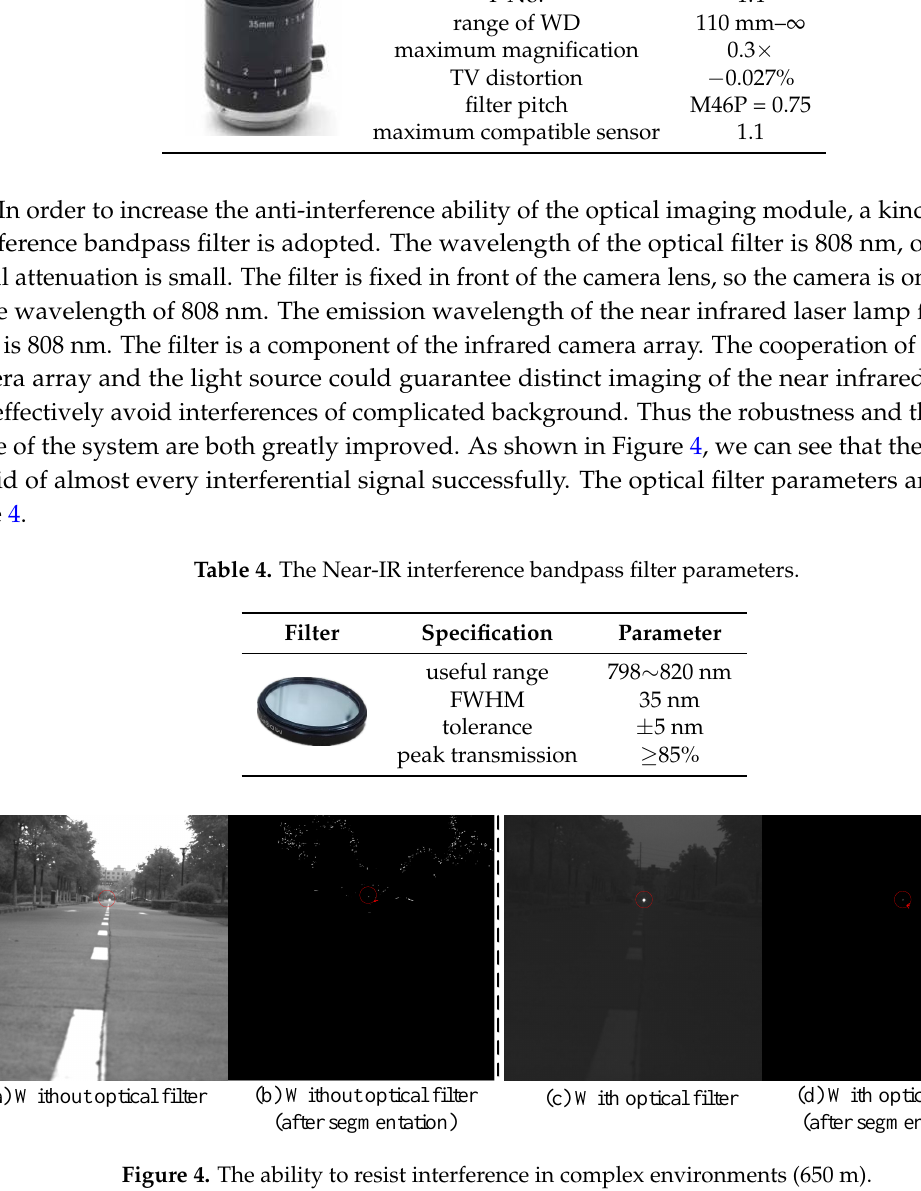
Figure 4. The ability to resist interference in complex environments (650